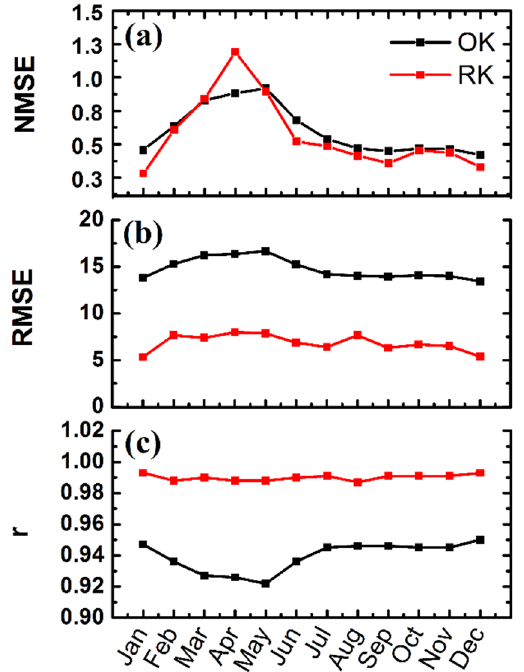
Figure 6. The assessment criteria for the OK and RK estimations based on Leave One-Out Cross-Validation (LOOCV) method, which represents the averaged values for each month: ( a ) Normalized Mean Square Error (NMSE), ( b ) Root Mean Square Error (RMSE), and ( c ) correlation coefficient (r).